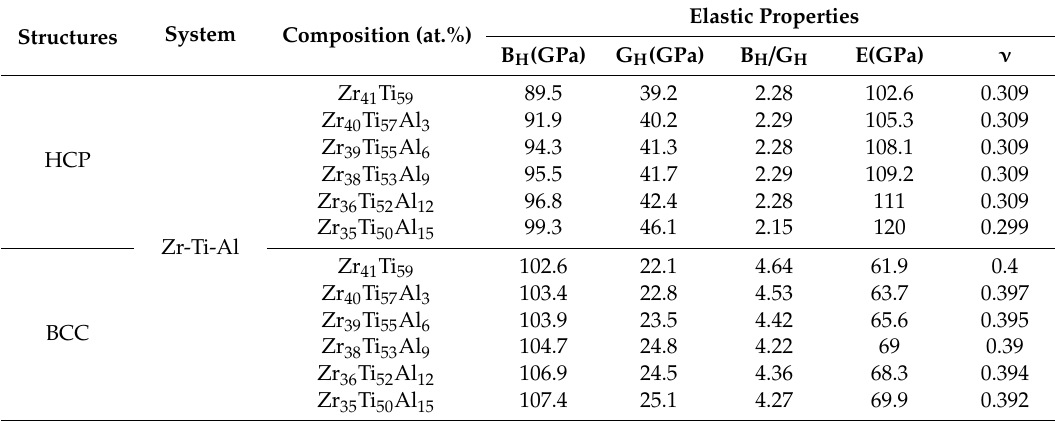
Table 9. Elastic properties of HCP structure and BCC structure Zr-Ti-Al alloy systems. Structures